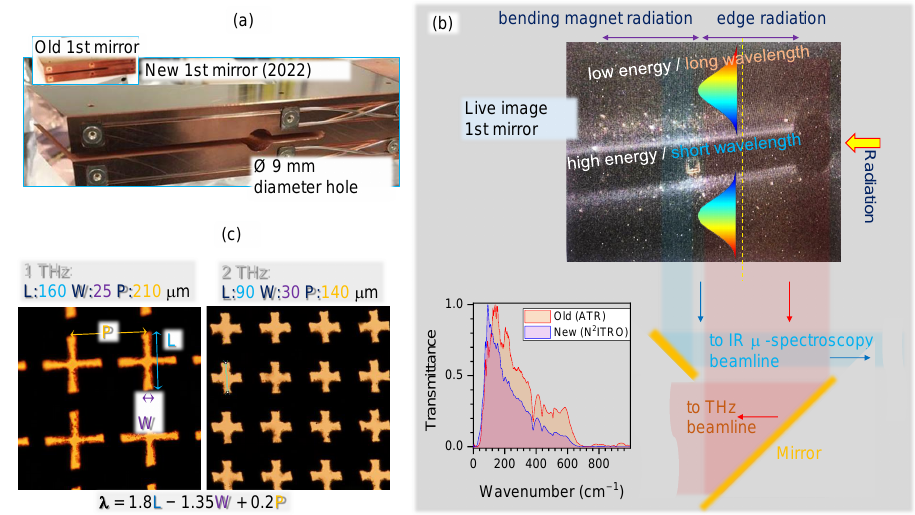
Figure 1. ( a ) Photo of the newly installed first mirror used for extracting the IR-THz radiation out of the storage ring at the AuSy (in use since January 2022). ( b , top ) Video camera feed of the 1st mirror with schematics of radiation split between two beamlines; visible light (part of synchrotron radiation) is apparent at the edges of the mirror. ( b , bottom ) Comparison of normalised transmittance observed before and after the replacement of the 1st mirror in ATR and Near-Normal Incidence Transmission and Reflection Optics (N 2 ITRO) modes, using a 6 µ m Mylar beamsplitter (see Appendix A, Figure A1). ( c ) Optical micro-images of 1 and 2 THz filters laser ablated out of 20- µ m-thick stainless steel SUS304 ( L , W , P are the length, width, and period of the cross